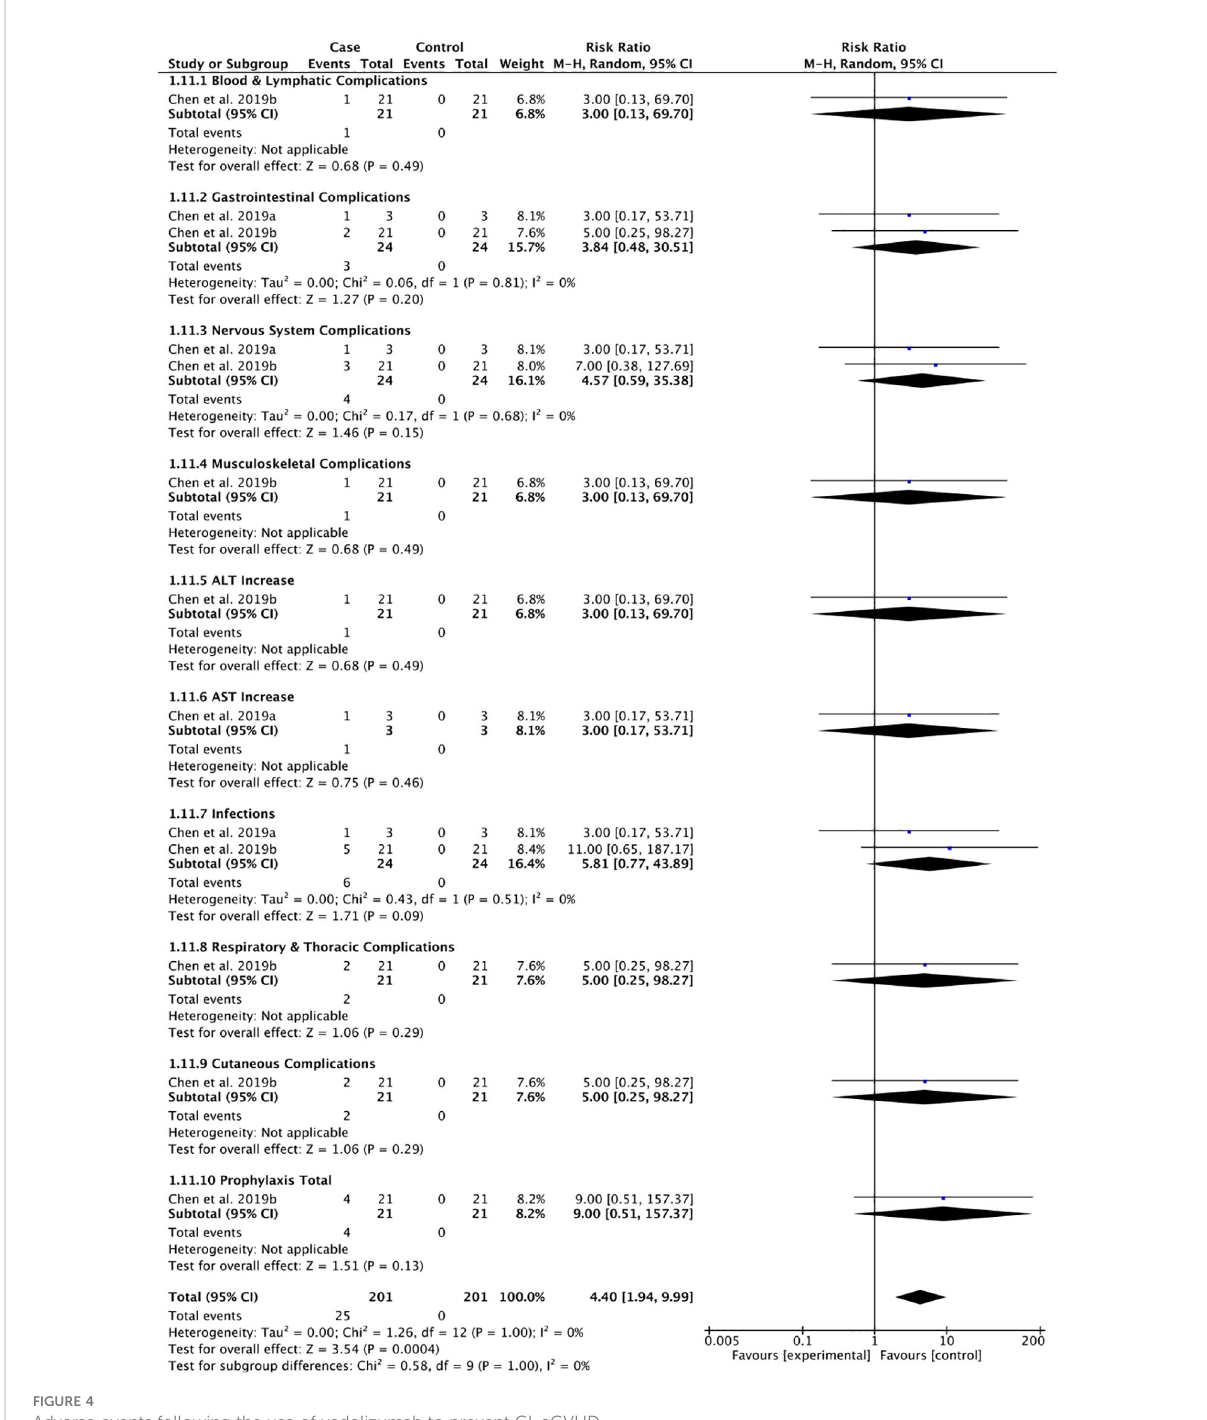
FIGURE 4 Adverse events following the use of vedolizumab to prevent